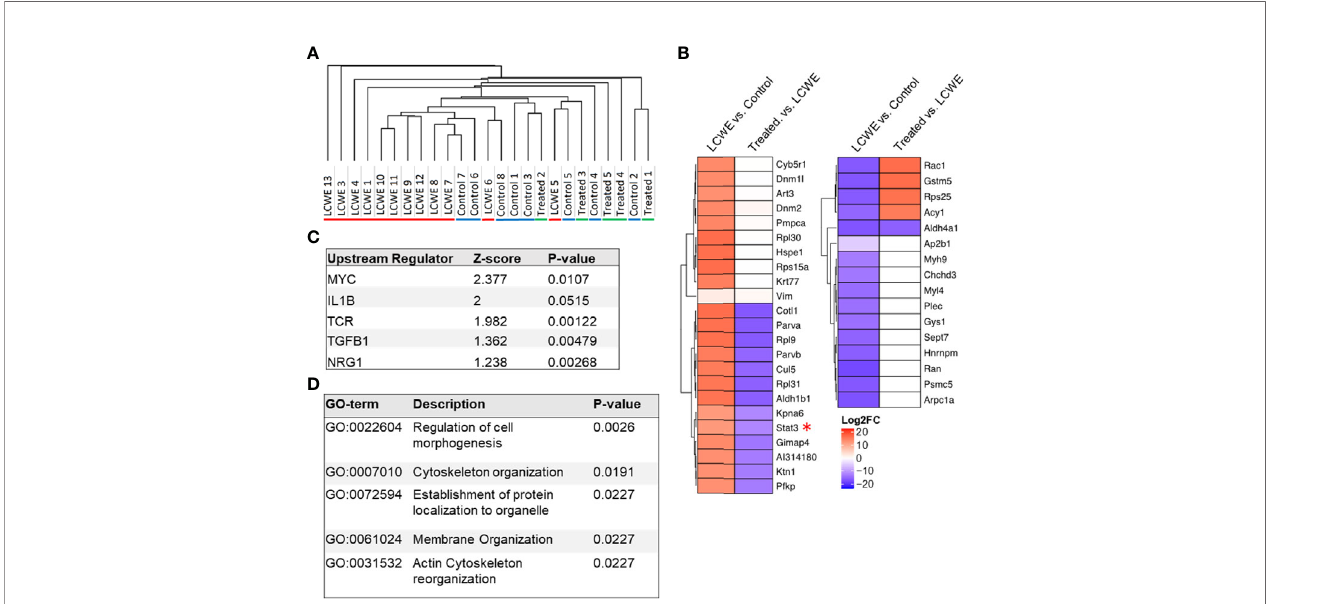
FIGURE 1 | Proteomics analysis of cardiac tissue using the LCWE induced mouse model of KD. (A) Hierarchical one-minus Pearson ’ s clustering. “ LCWE ” indicates LCWE-injected mice (n=13), “ Control ” indicates PBS injected mice (n=8), and “ Treated ” indicates LCWE injected mice treated with anakinra (n=5). (B) Heatmap of fold change for proteins found differentially expressed (FC > 2, p<0.05) between LCWE-injected mice and PBS controls or between anakinra-treated LCWE and untreated LCWE mice. (C) Top regulators (ranked by z-score) identi fi ed by IPA Upstream Analyses of proteins differentially expressed (FC > 2, p<0.05) between KD mice and PBS controls. D) STRING Gene Ontology Biological Process analyses of proteins differentially expressed (FC > 2, p<0.05) between KD mice and PBS